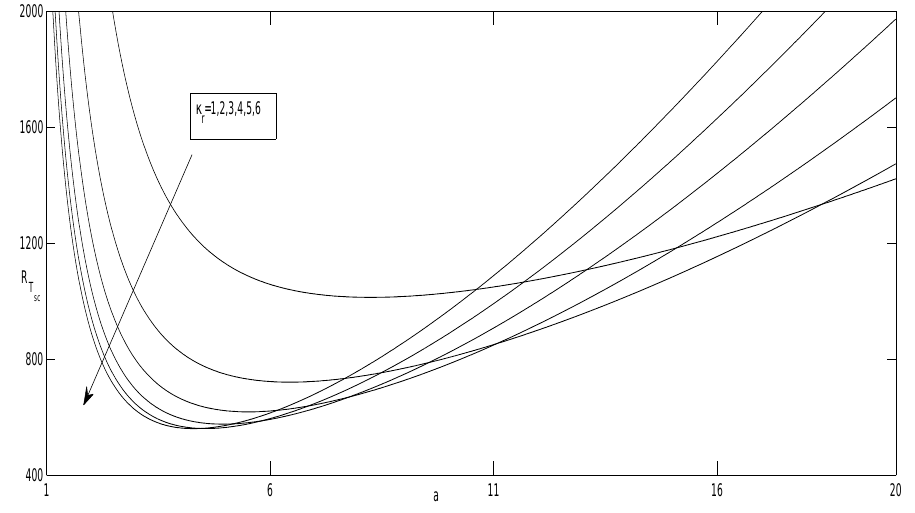
Figure 5. Neutral curves for the different values of κ r and for the fixed values of γ = 0.5, η = 0.2, R C = 50, S = 0.2, and Ta = 50 for the stationary mode.